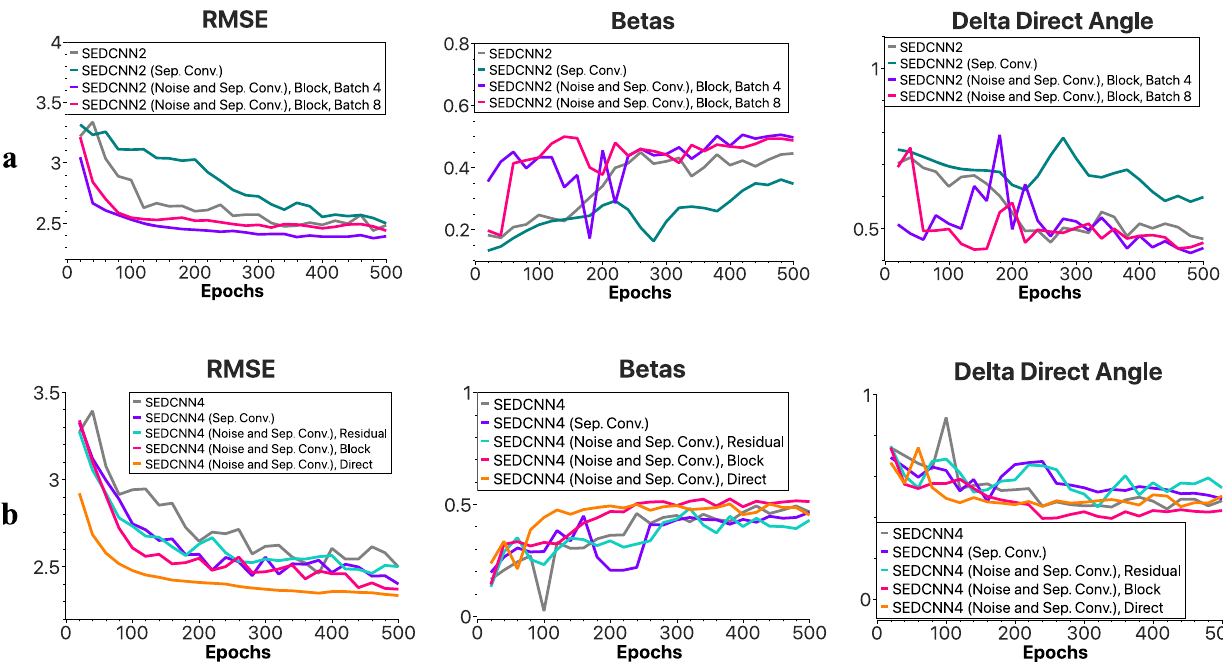
Fig. 7 Performance gain using noise learning. Serial optimizations of a SEDCNN2 and b SEDCNN4. Similar to Fig. 6, RMSE, Betas, and Delta Direct Angle were illustrated. Noise learning approach made up for the performance loss incurred by Sep. Conv. Units for RMSE and Betas: arbitrary units, and for Delta Direct Angle: degrees.